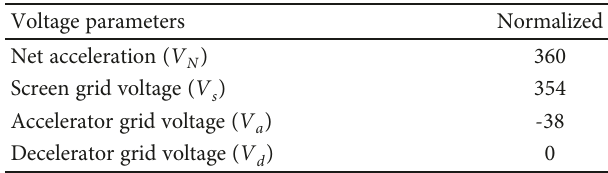
Table 2: Normalized operating conditions for the ion optics [12].